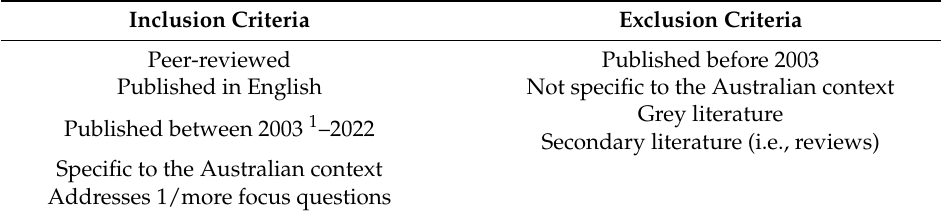
Table 1. Inclusion and Exclusion